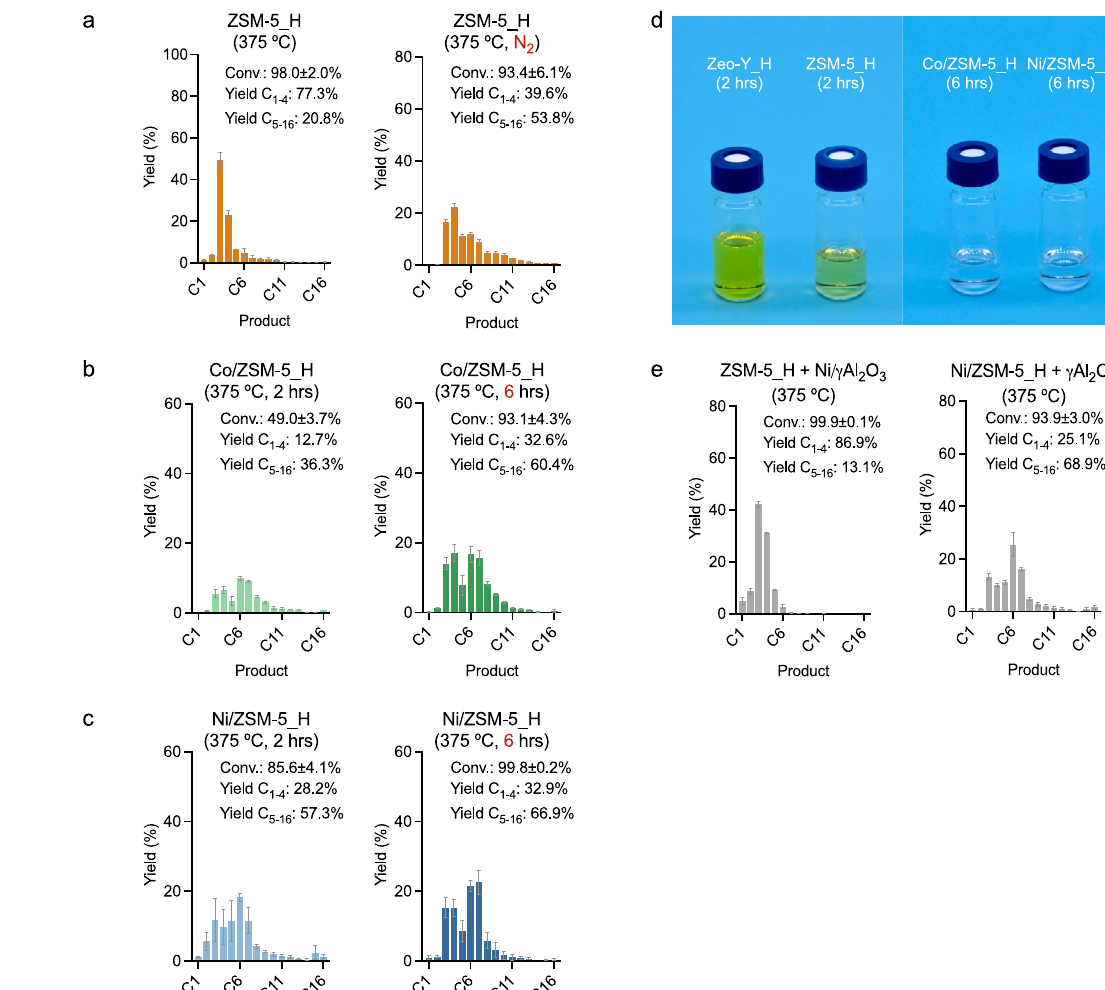
products from the nC 16 deconstructions using Zeo-Y_H, ZSM-5_H, Co/ZSM-5_H, and Ni/ZSM-5_H with 45 bar H 2 at 375°C. e nC 16 (1.59g, 7.0mmol) deconstruction using Ni/ZSM-5_H (0.1g, metal loading=2.5 wt%)+ γ Al 2 O 3 (0.1g) and ZSM-5_H (0.1g)+ Ni/ γ Al 2 O 3 (0.1g, metal loading=2.5 wt%), 45 bar H 2 , 2h. Error bars=standard deviation. Source data are provided as a Source Data fi